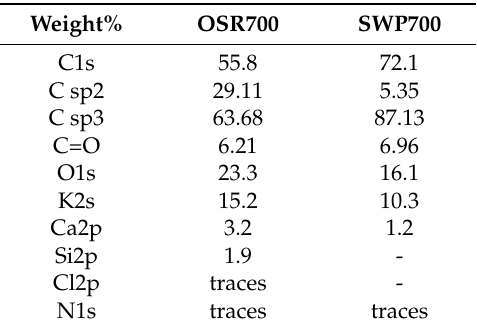
Figure 4. High resolution X-ray photoelectron spectroscopy (XPS) spectra of C1s peak for ( a ) OSR700; ( b ) SWP700. Table 3. Weight% resulted from XPS characterization.